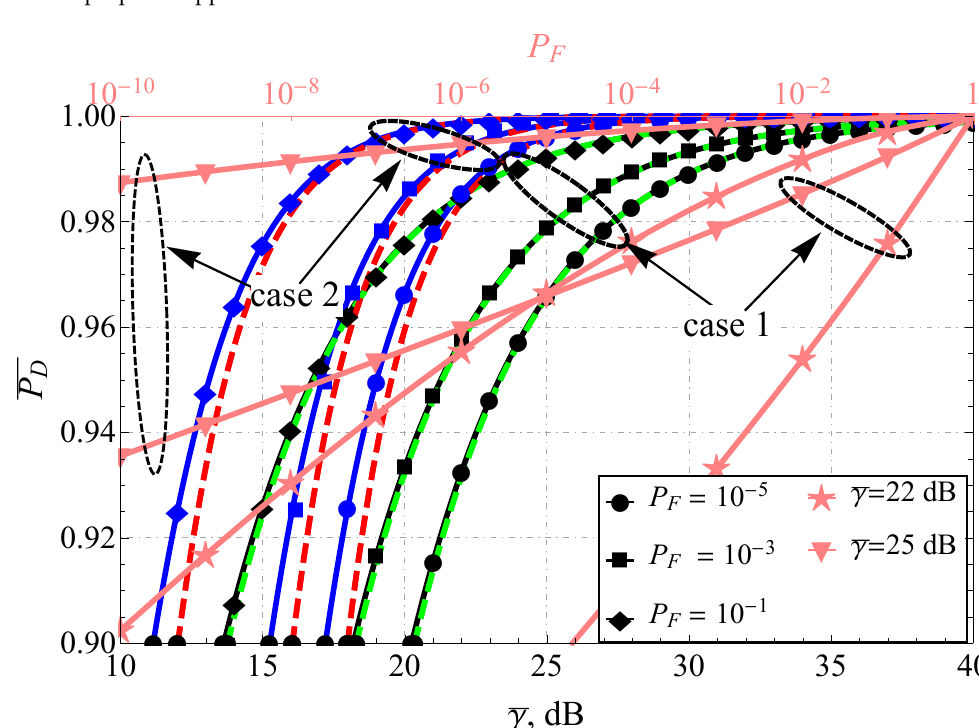
Figure 2. P BX D comparison for various P D and u = 2.2: black lines (case 1)— m X = 1, m Y = 2, Ω = − 1 dB, Ω = 1 dB, blue lines (case 2)— m X Y and green lines—proposed